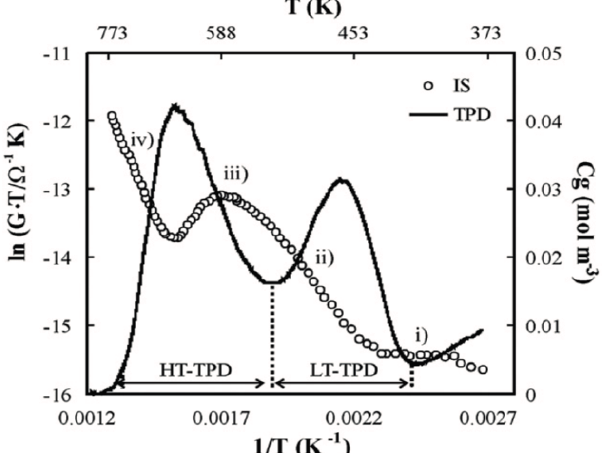
Figure 11. NH 3 -TPD profile and logarithm of the proton conductivity of H-ZSM-5 (Si/Al = 80) versus the reciprocal temperature. The plots show the thermal desorption of NH 3 adsorbed on different sites at low and high temperatures and the corresponding change in proton conductivity. (i)–(iv) denote different characteristic temperature ranges as shown in Figure 10 [21]. Reprinted with permission from